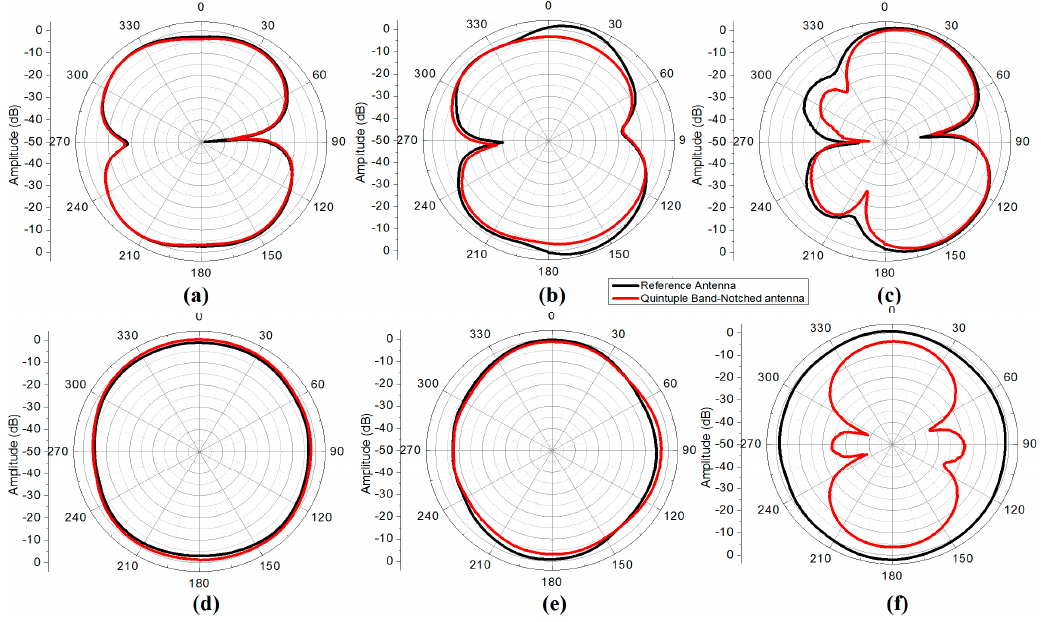
Figure 11. Measured radiation patterns of the reference vs. quintuple band-notched antenna ( a ) XZ plane (3.9 GHz); ( b ) XZ plane (6.1 GHz); ( c ) XZ plane (7.8 GHz); ( d ) YZ plane (3.9 GHz); ( e ) YZ plane (6.1 GH z); ( f ) YZ plane (7.8 GHz).